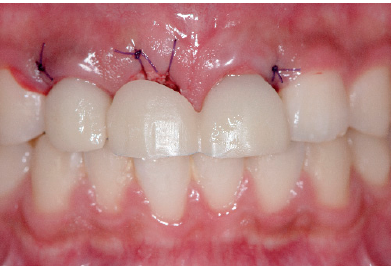
Figure 4. Placement of a set of provisional restorations immediately after implant surgery.